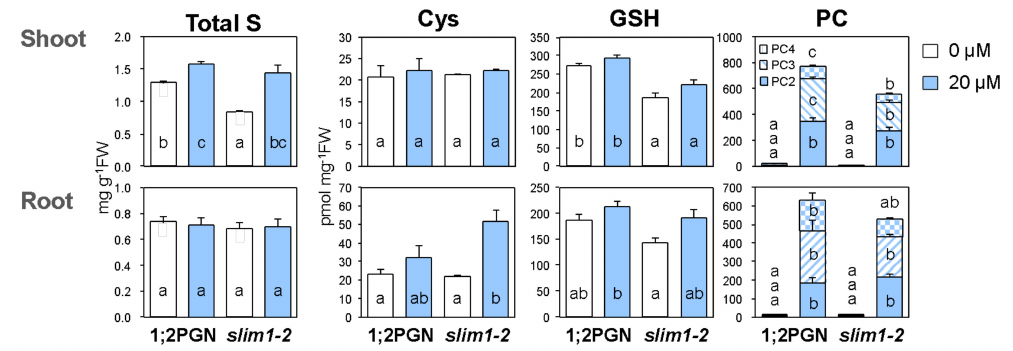
Figure 4. E ff ects of Cd treatment on the total content of S, Cys, GSH, and PC in 1;2PGN and slim1–2 . 1;2PGN and slim1–2 were grown for 10 days on MGRL agar medium containing 0 (white bars) or 20 (light blue bars) µ M CdCl 2 . Shoot and root tissues of 1;2PGN and slim1-2 were used as samples. Total S content was analyzed by ICP-MS. Contents of Cys, GSH, and PCs were analyzed using a HPLC-fluorescence detection system after labeling the thiol bases with monobromobimane. Cys: Cysteine, GSH: Glutathione, PC: Phytochelatin. The average values are indicated with error bars denoting SEM ( n = 3–4). Di ff erent letters indicate significant di ff erences among experimental groups (Tukey-Kramer test; p <